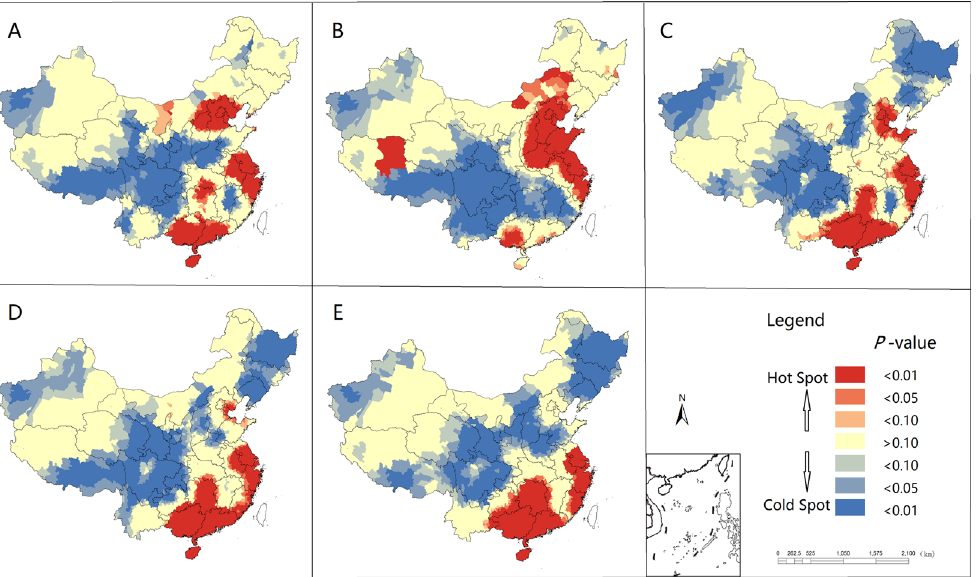
Fig 5. Local Indicators of Spatial Association (LISA) significance maps for the incidence of HFMD in mainland China, 2008 (A) to 2012 (E). Red indicates concentrated outbreaks, and blue indicates a low